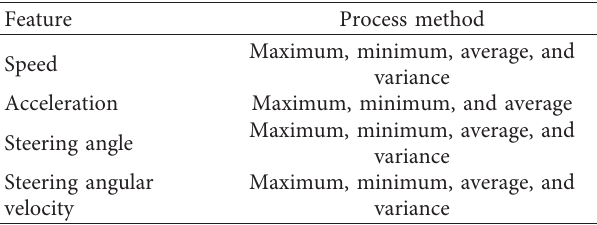
Table 1: Vehicle kinematics data processing